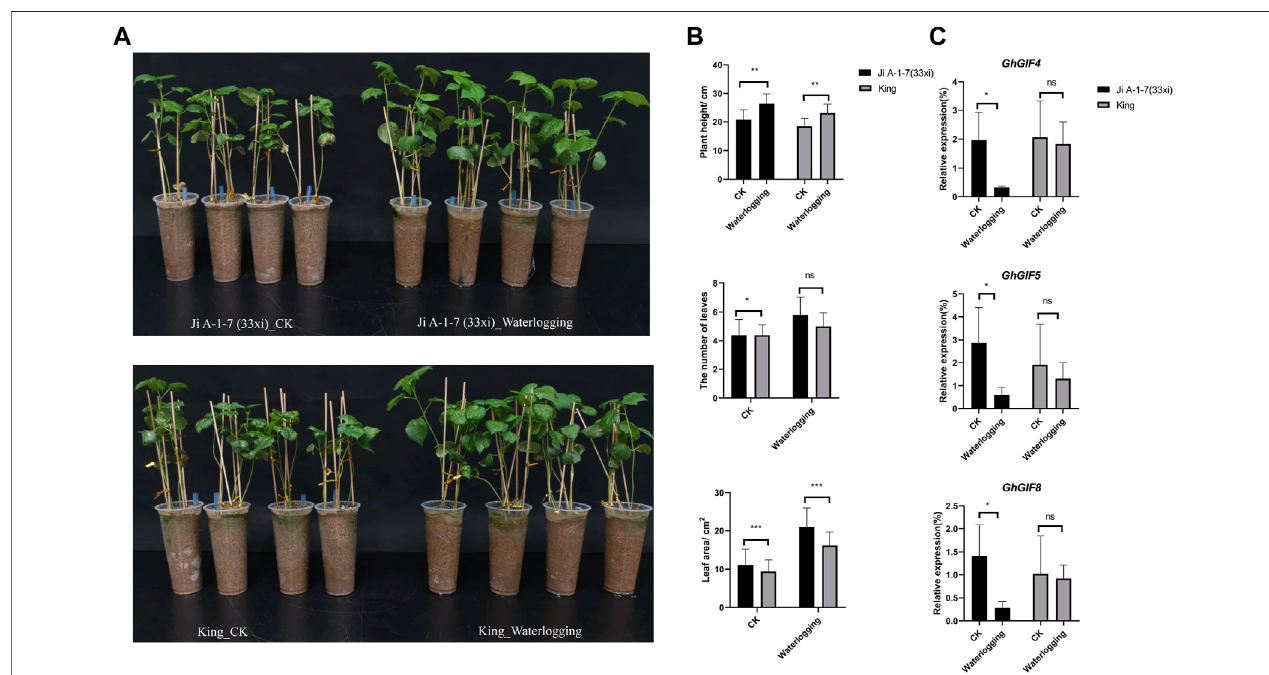
FIGURE 6 | Response of GhGIF genes to waterlogging. (A) The phenotype of Ji A-1-7 (33xi) and King under waterlogging stress (B) Count of plant height, lateral root numbers, and the leaf areas (C) Relative expression of GhGIF4 , GhGIF5 , and GhGIF8 in leaves of waterlogging and its control (CK)